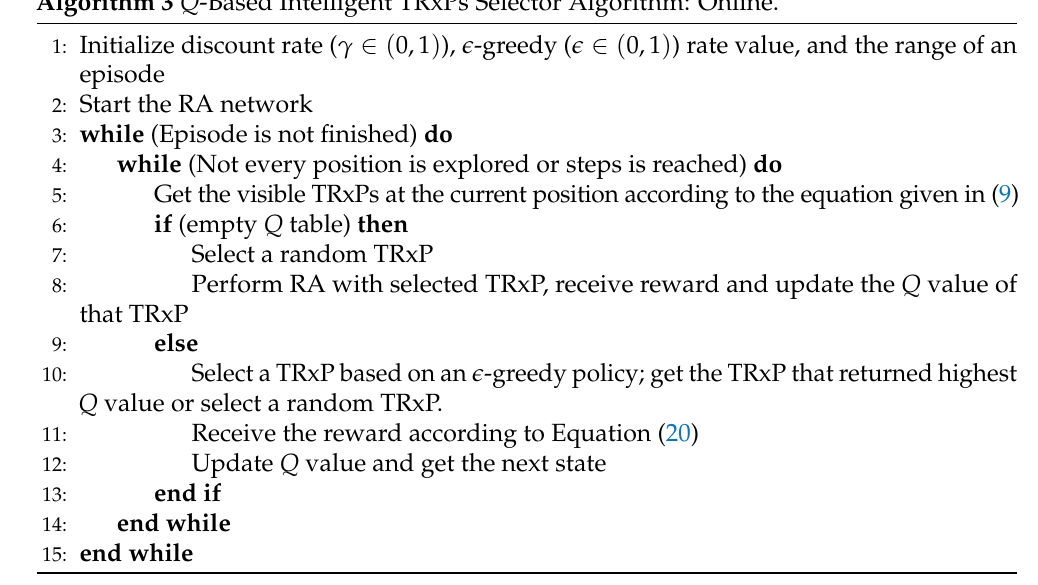
Algorithm 3 Q -Based Intelligent TRxPs Selector Algorithm: Online.